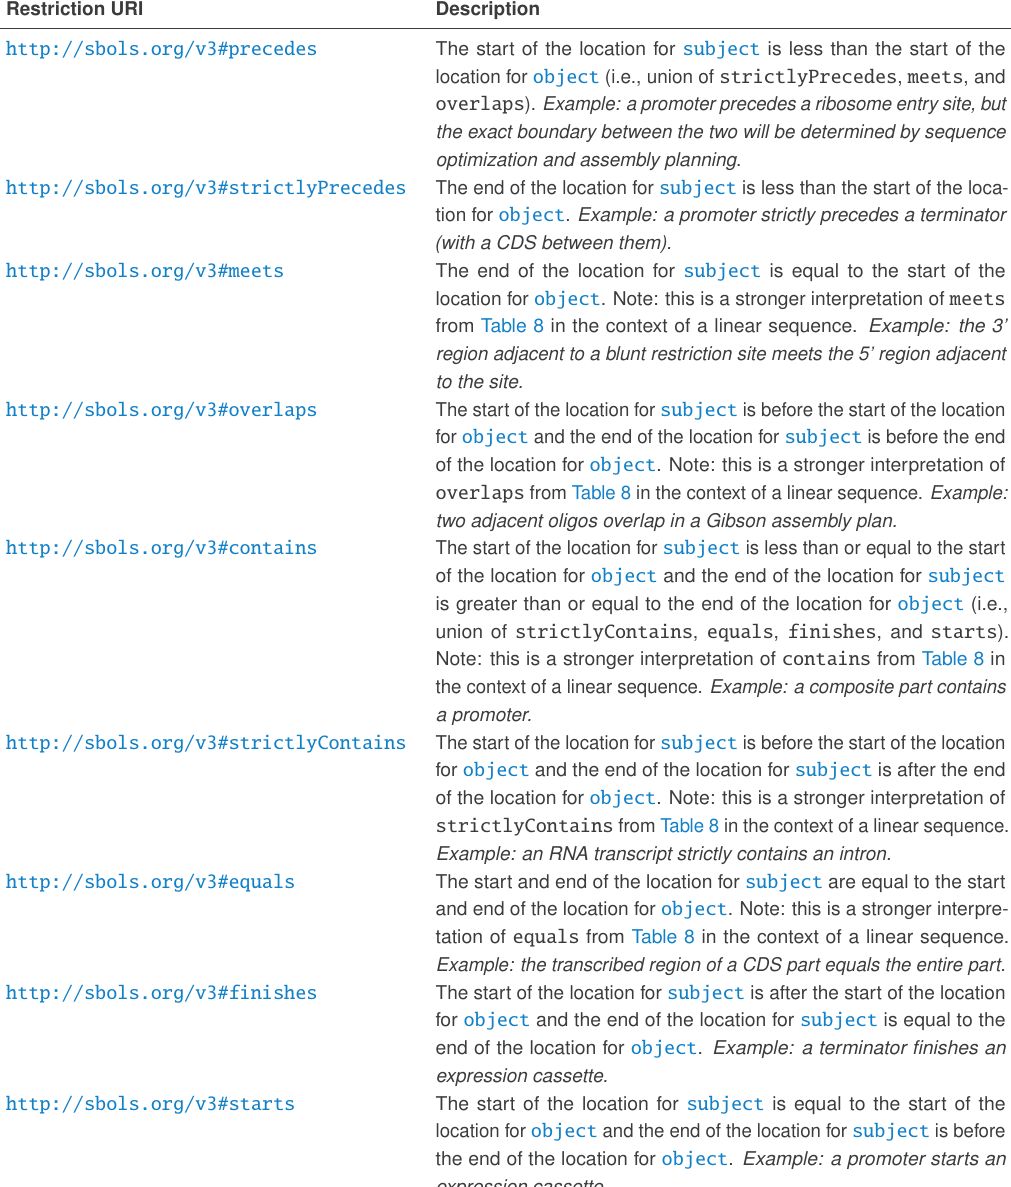
Table 9: RECOMMENDED URI s for expressing sequential relations with the restriction